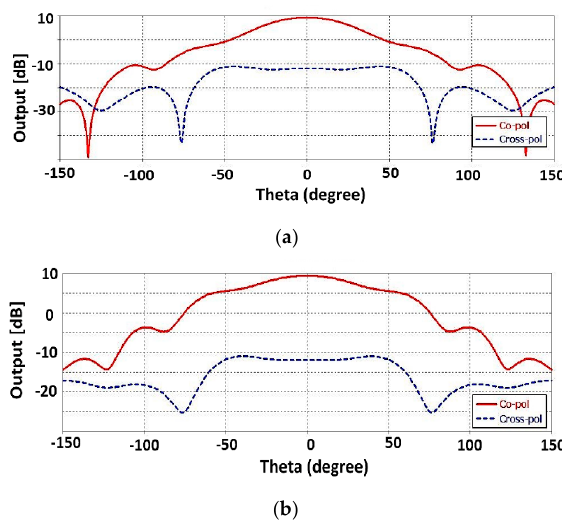
Figure 8. Co- and cross-pol performances of Vivaldi antenna at 25 GHz; E-plane ( a ), H-plane ( b ).